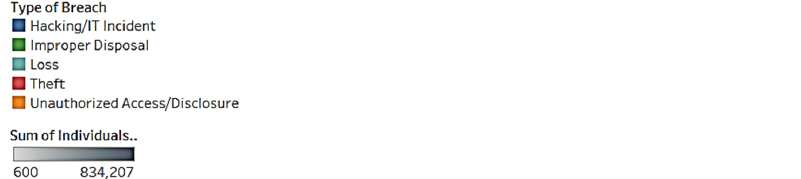
Figure 21. Geographical distribution of affected individuals by state and type of breach.